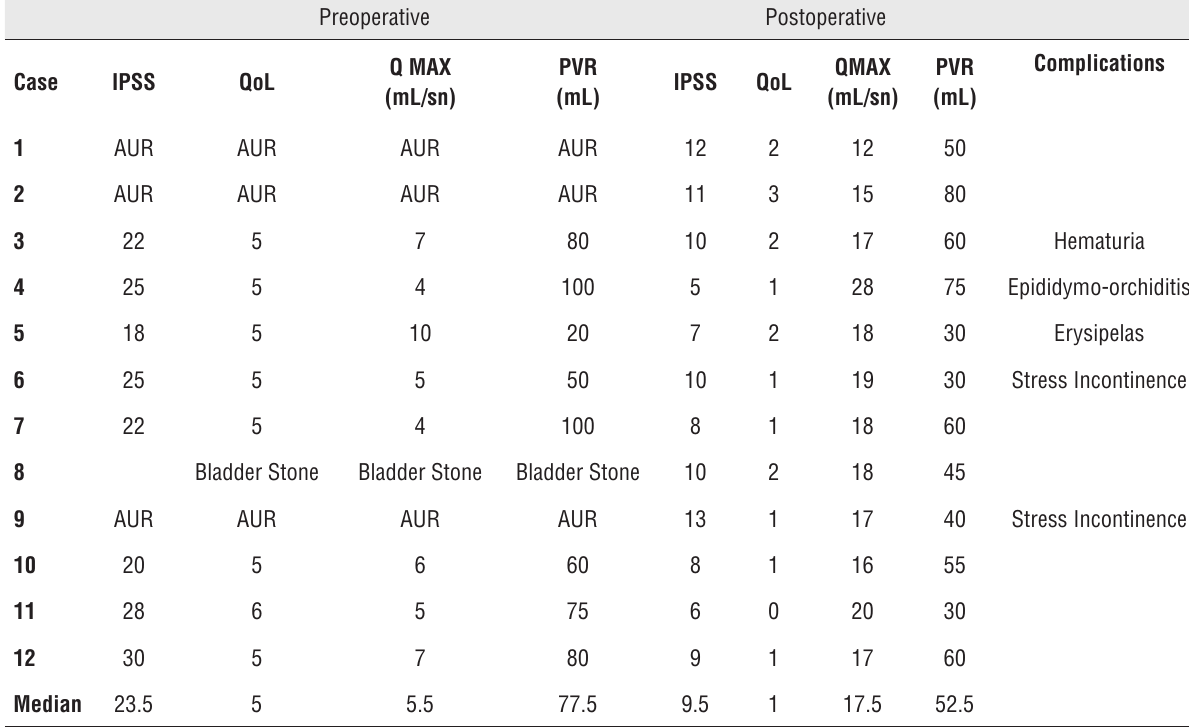
Table 1 - comparison of preoperative and postoperative data. Preoperative